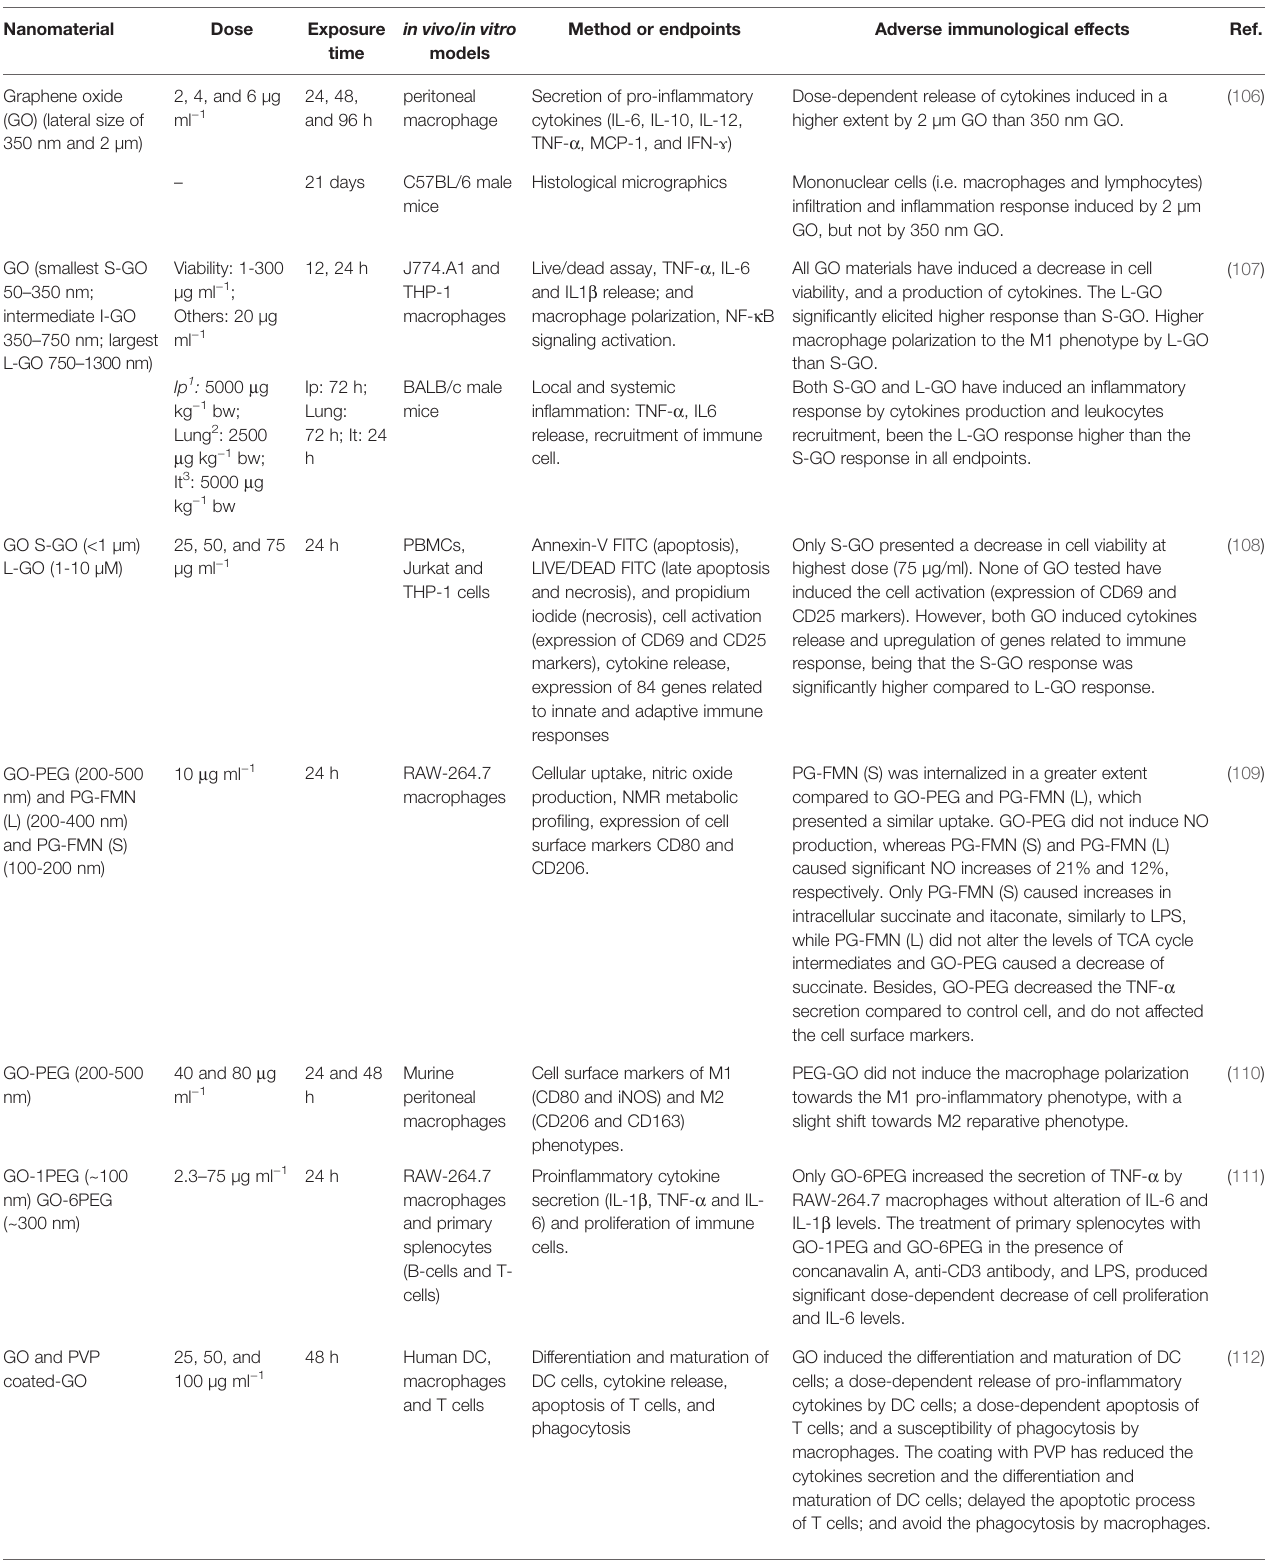
TABLE 1 | Relevant studies addressing the adverse immunological effects of 2D materials in in vitro and in vivo models from 2000 to 2021. in vivo / in Nanomaterial Dose Exposure time